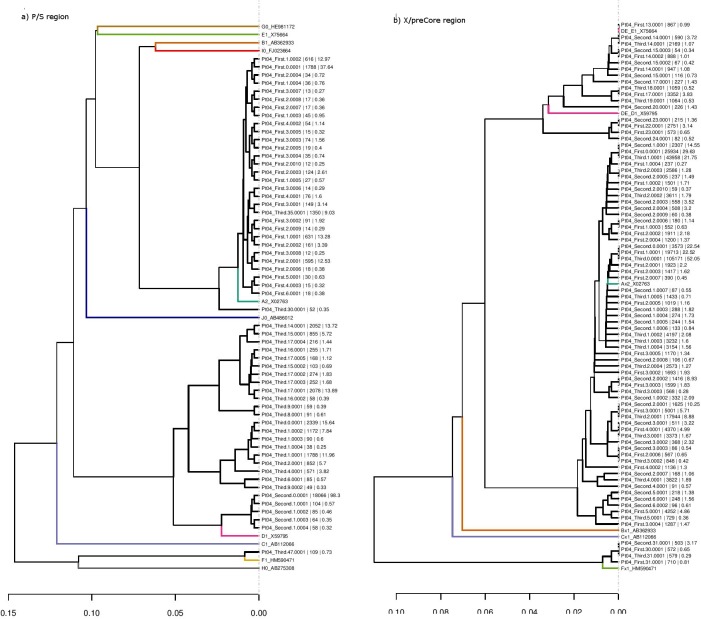
UPGMA tree obtained from the polymerase/surface (a) and the X/preCore (b) regions of the three samples from Pt 4.The main haplotype of the first sample (First.0.0.0001) was genotyped as A, whereas the main haplotype of the second and third sample (Second.0.0.0001 and Third.0.0.0001) was genotype as D. At the X/preCore region, the main genotype was A, but Gen/DE and F haplotypes were also observed. Genotype reference sequences for the two regions: A2_X02763; B1_AB362933; C1_AB112066; D1_X59795 (for P/S region); DE_ D1_X59795 (for X/preCore region); E1_X75664 (for P/S region); DE_E1_X75664 (for X/preCore region); F1_HM590471; G0_HE981172; H0_AB275308; I0_FJ023664; J0_AB486012.